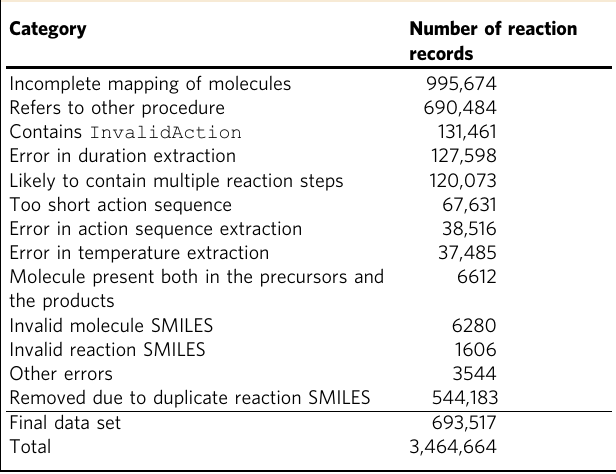
Table 2 Reaction records ignored during the generation of the data